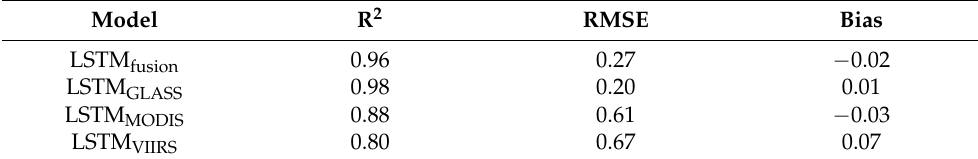
Table 2. Theoretical performances of the LSTM models.